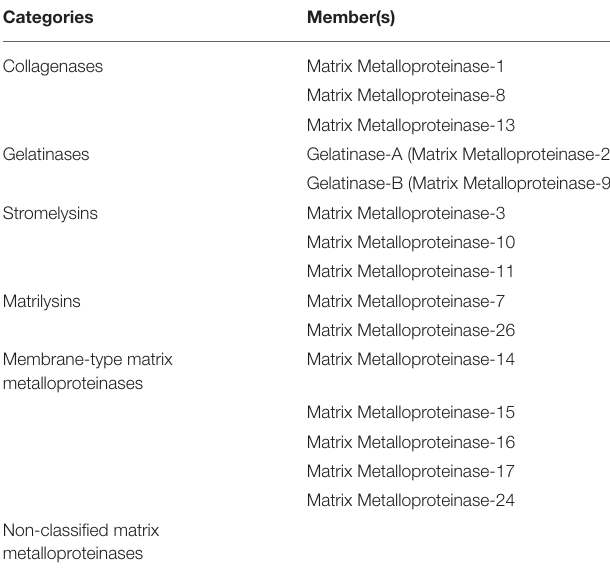
TABLE 4 | Categories of Matrix Metalloproteinase-1 and their corresponding